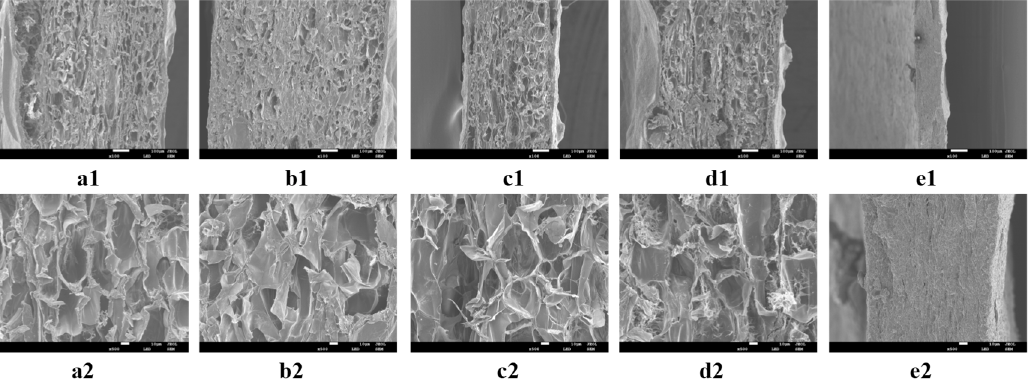
Figure 3. The microstructure of L. japonica treated by different processing methods was observed by scanning electron microscope.×100: ( a1 ) raw; ( b1 ) blanched; ( c1 ) steamed; ( d1 ) boiled; ( e1 ) baked. ×500: ( a2 ) raw; ( b2 ) blanched; ( c2 ) steamed; ( d2 ) boiled; ( e2 ) baked.